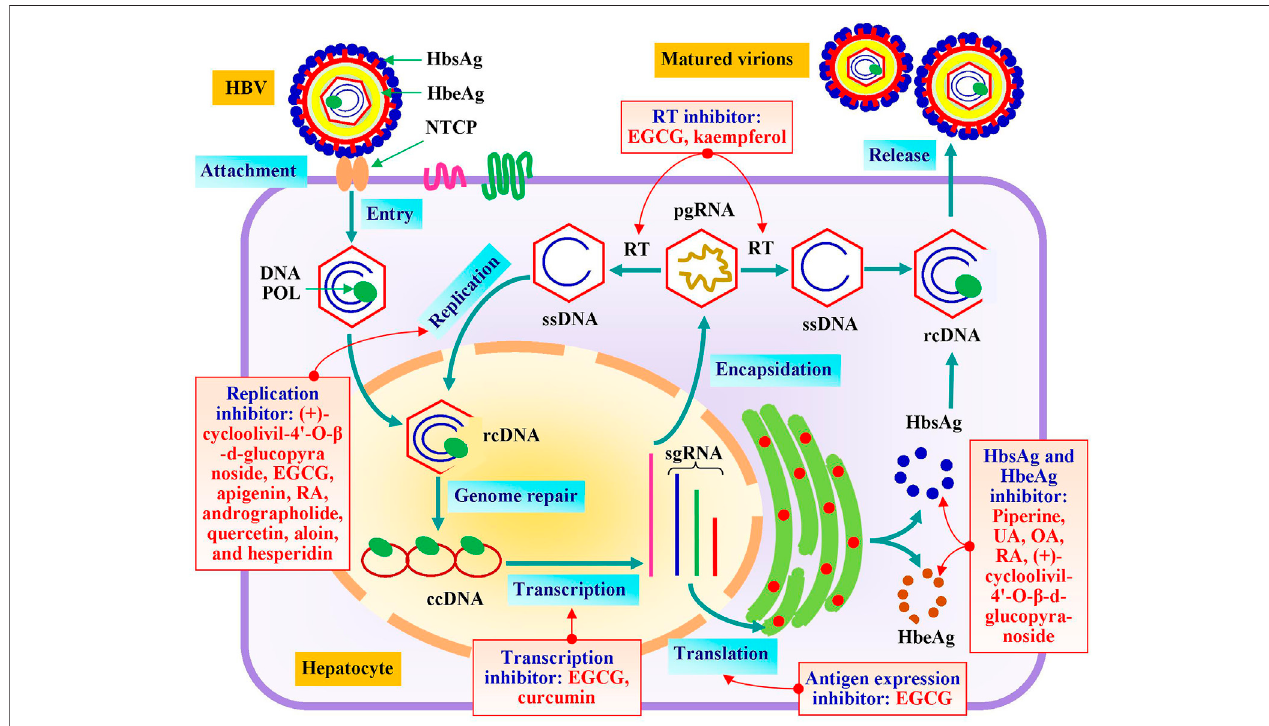
FIGURE 3 | Impact of bioactive metabolites derived from Bangladeshi medicinal plants on molecular targets of HBV. NTCP, Na + -taurocholate co-transporting polypeptide; DNA POL, DNA polymerase; RT, reverse transcriptase; rcDNA, relaxed circular DNA; ccDNA, closed circular DNA; pgRNA, pre-genomic RNA; HbsAg,